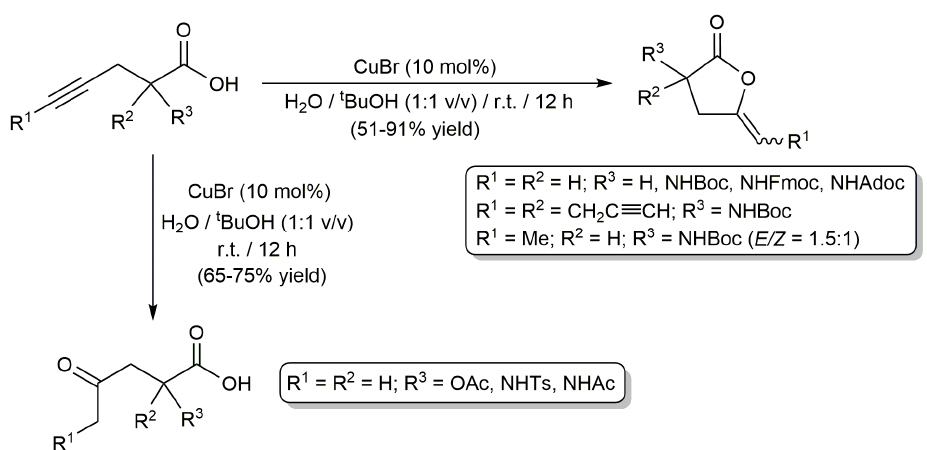
Scheme 9. CuBr-catalyzed transformations of different γ -alkynoic acids in aqueous medium.